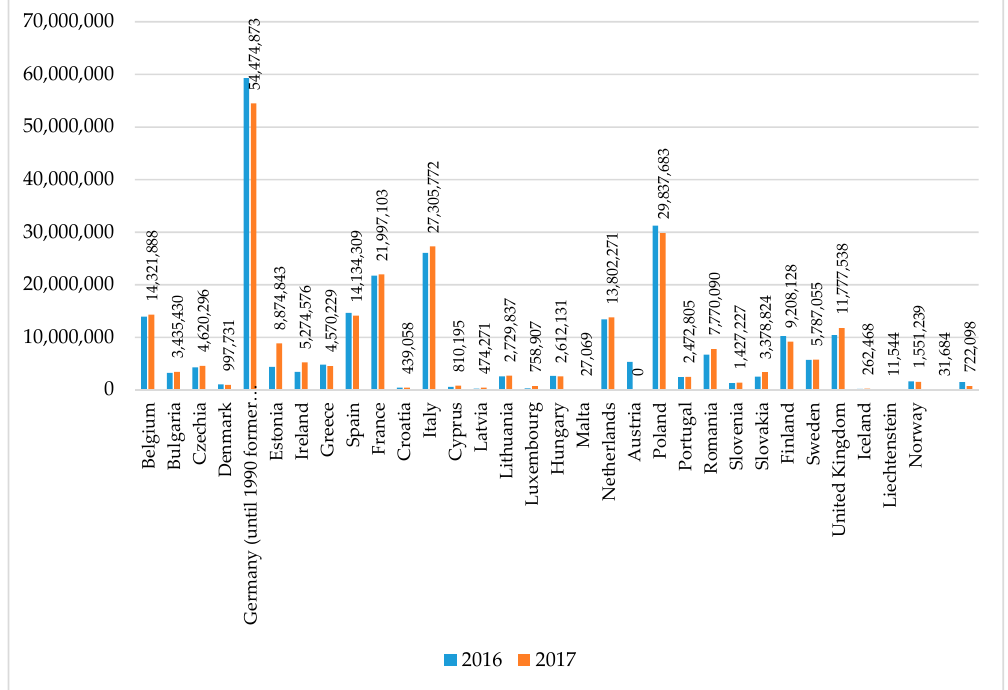
Figure 4. The quantity of waste generated by the manufacturing industry in EU countries for the period 2016–2017 (tons) [45].